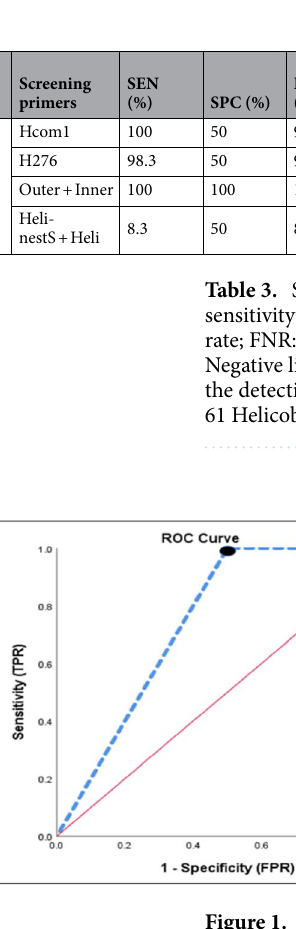
Figure 1. ROC curve of In silico comparison by PCR amplification. Null hypothesis: true area = 0.5, AUC. ( A ), ROC curve of ConsH and Hcom1 primers for detection of 62 Helicobacter strains, AUC represents the accuracy of the screening test (0.750). ( B ), ROC curve of ConsH and H276 primers, AUC represents the accuracy of the screening test (0.742). ( C ), ROC curve of ConsH and Outer + Inner primers, AUC represents the accuracy of the screening test